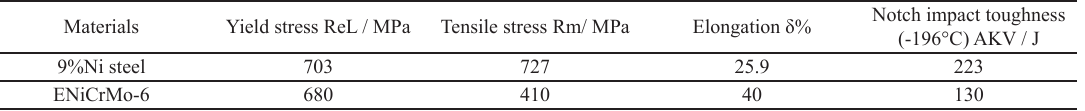
Table 2. Mechanical properties of 9Ni% steel and deposited metal of ENiCrMo-6. Materials